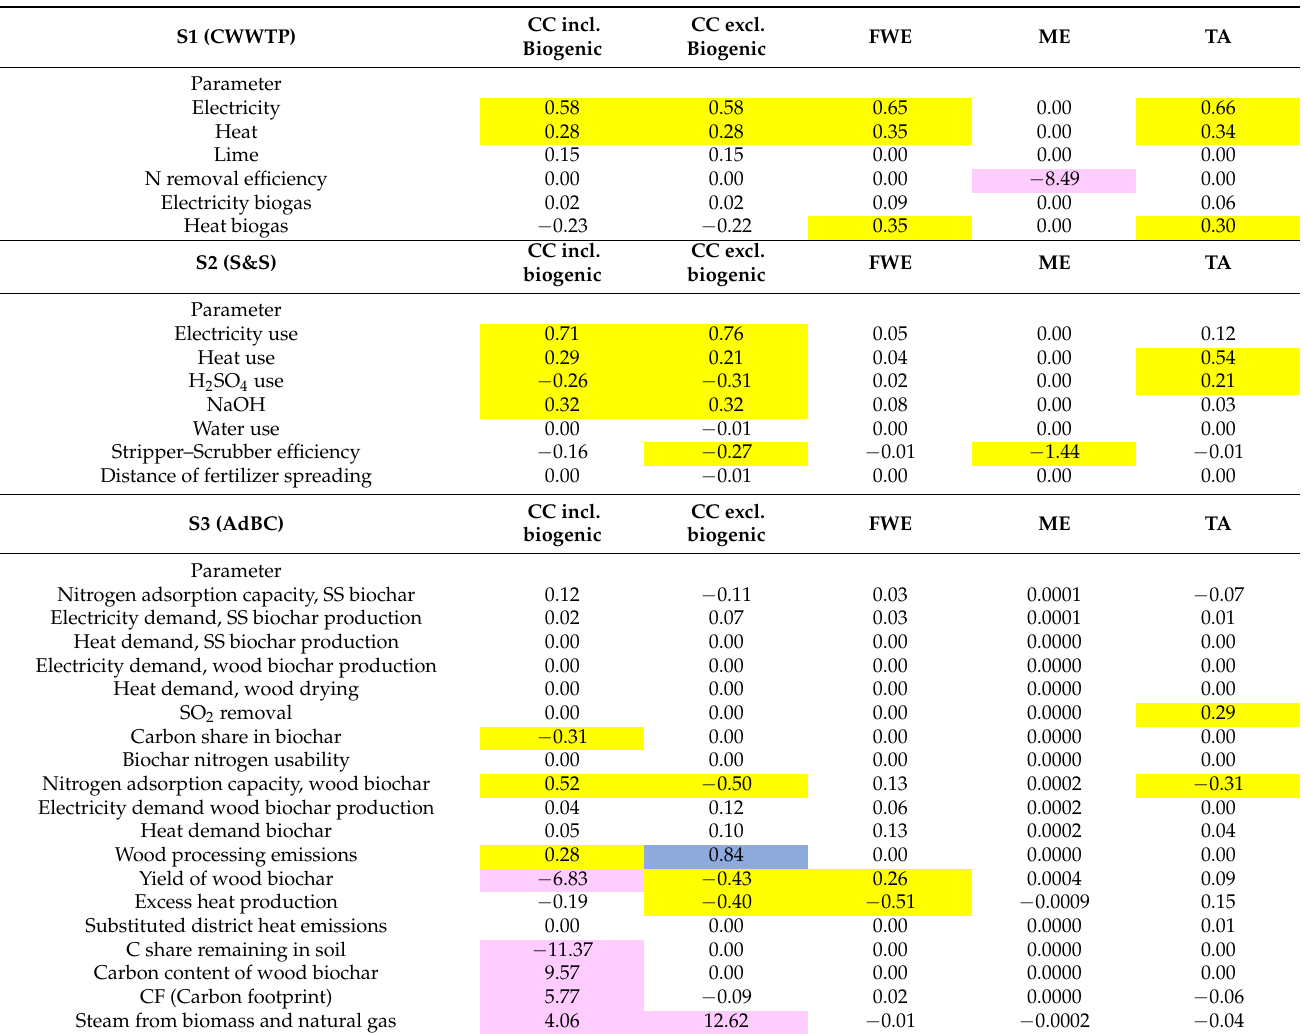
Table 2. Sensitivity ratios (SRs) for parameters in each scenario against selected impact categories. |SR| > 1 Particularly important, |SR| = 0.8–1 Important parameter, |SR| = 0.2–0.8 |SR| < 0.2 Minor importance.